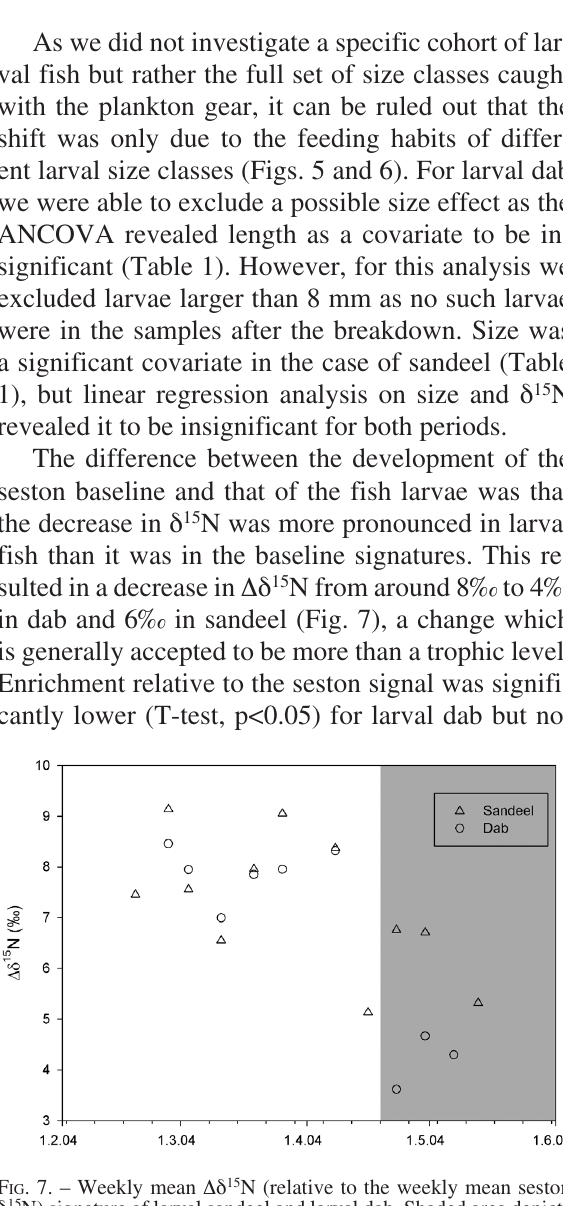
the timeframe after the zooplankton